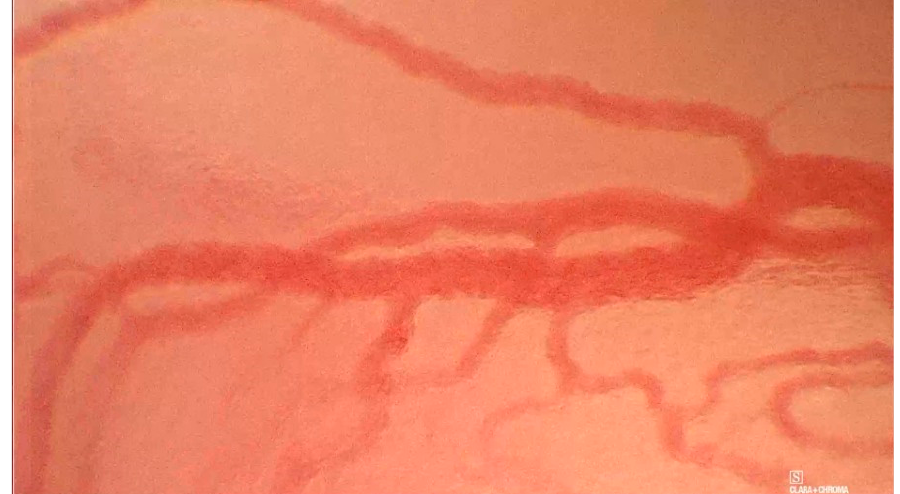
Figure 4. Histologically verified polyp of the left vocal cord. Puxxedu classification type I.